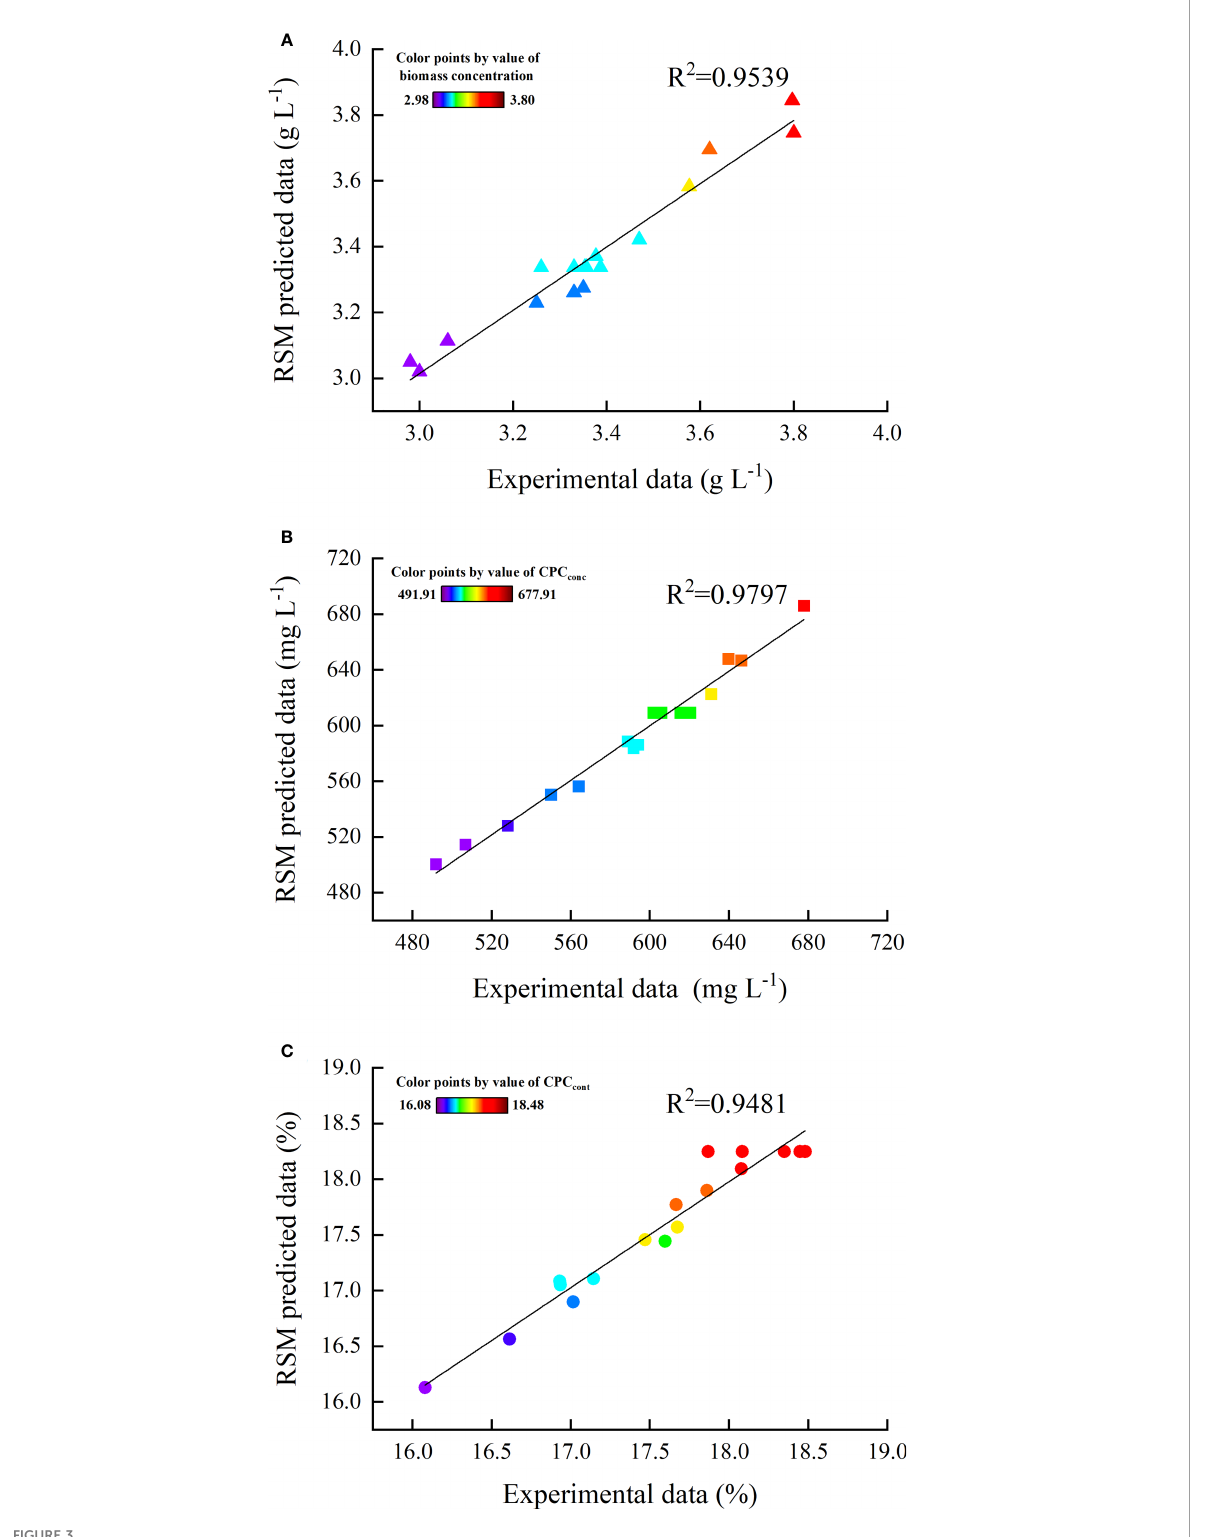
FIGURE 3 Comparison between experimental and predicted values of (A) biomass concentration, (B) CPC conc , and (C) CPC cont